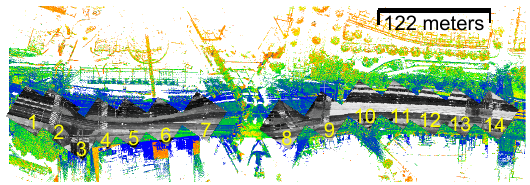
Figure 2. Visualization of the MLSPC of the test area and cropped tiles.